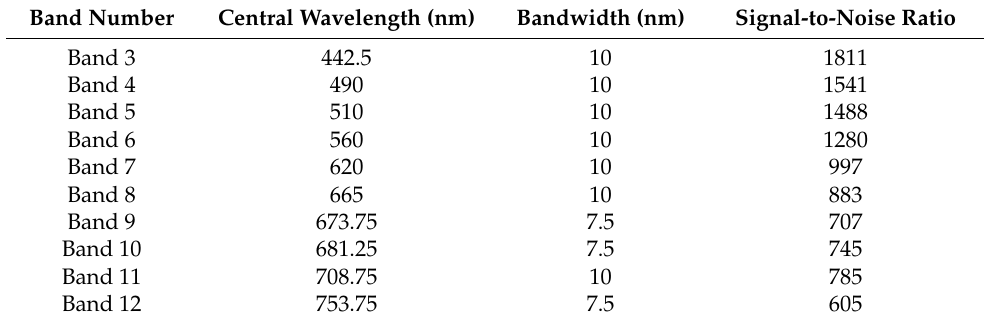
Table 1. Summary of the S3 Ocean and Land Color Instrument (OLCI) spectral bands used in this